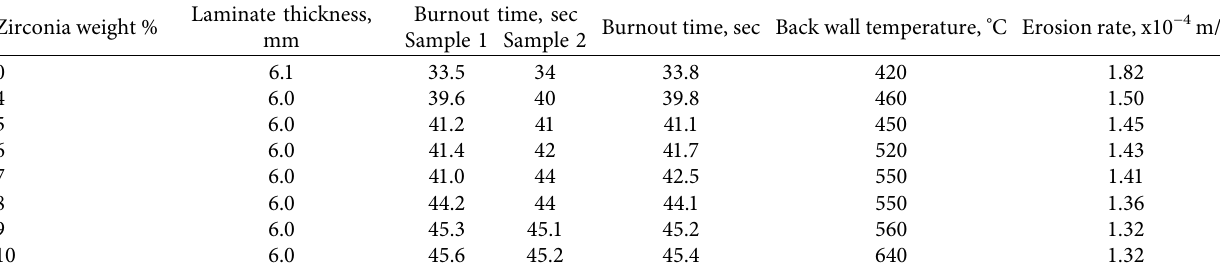
Table 6: Thermal erosion of nanozirconia C-Ph composite